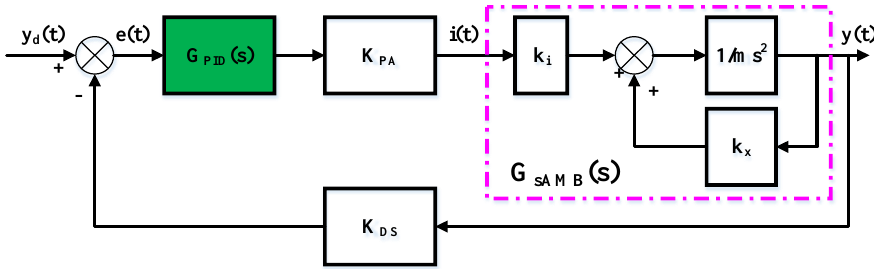
Figure 5. A SISO closed-loop feedback control system for the single DOF AMBs.